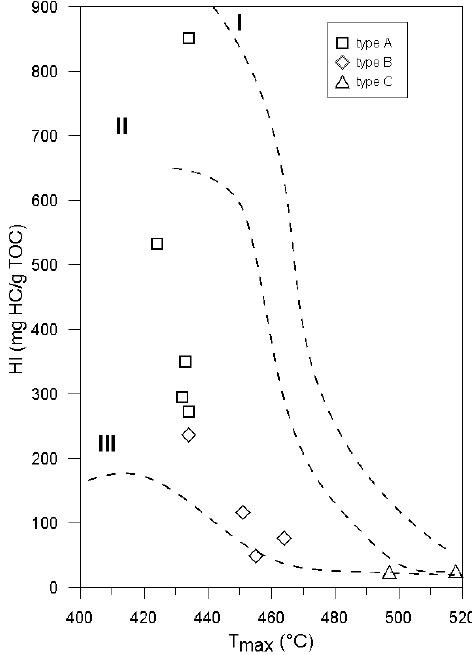
Figure 4. The modified van Krevelen plot with hydrogen index (HI) versus thermal maturity (T max ), which enables discerning the prevailing kerogen type of the studied source rocks.